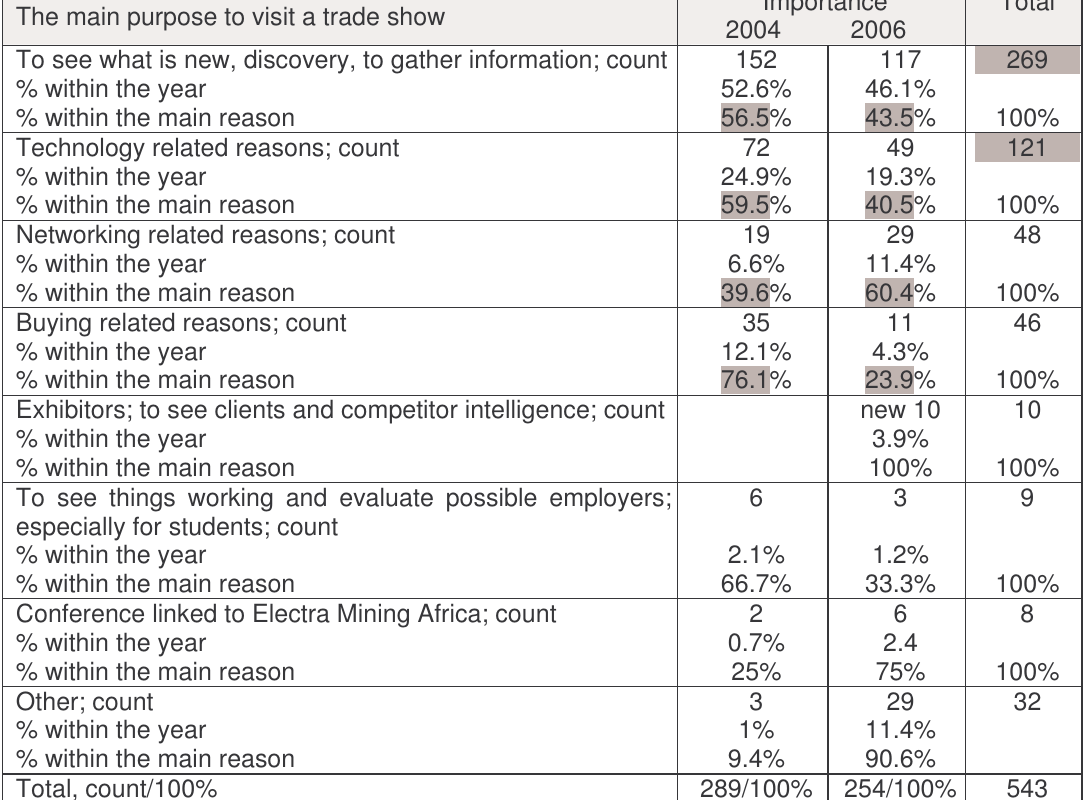
Table 4: The main purpose to visit a trade show in order of